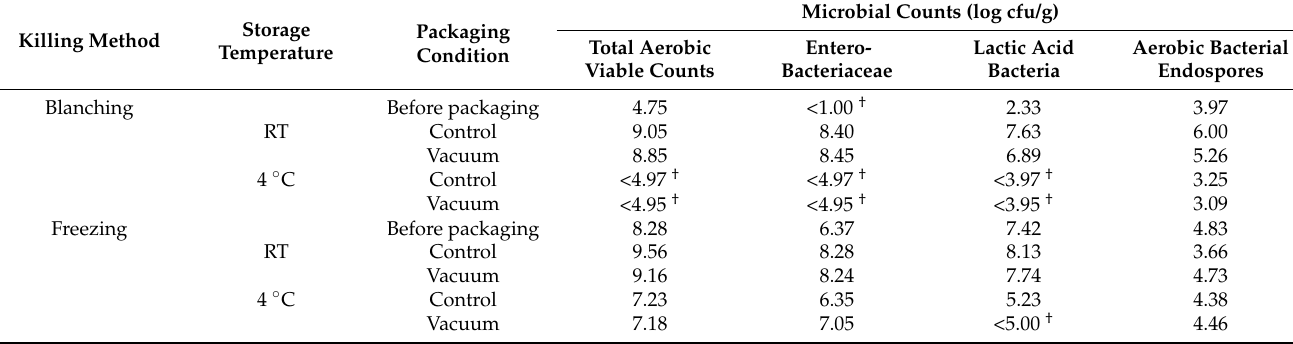
Table 2. Microbial counts before and after 6 days of storage without applying vacuum (control) or in vacuum, at room temperature (RT) or at 4 ◦ C and for larvae that were killed by either blanching or freezing. Results originate from one